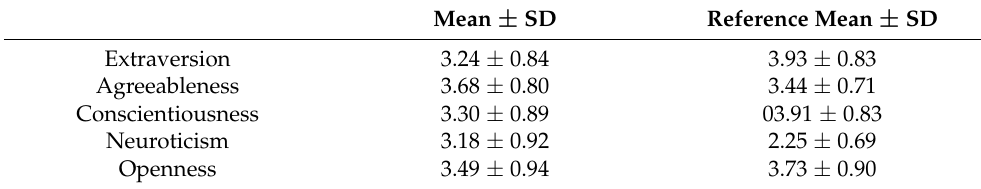
Table 1. Result of BFI-10 and a reference value of the respective group.